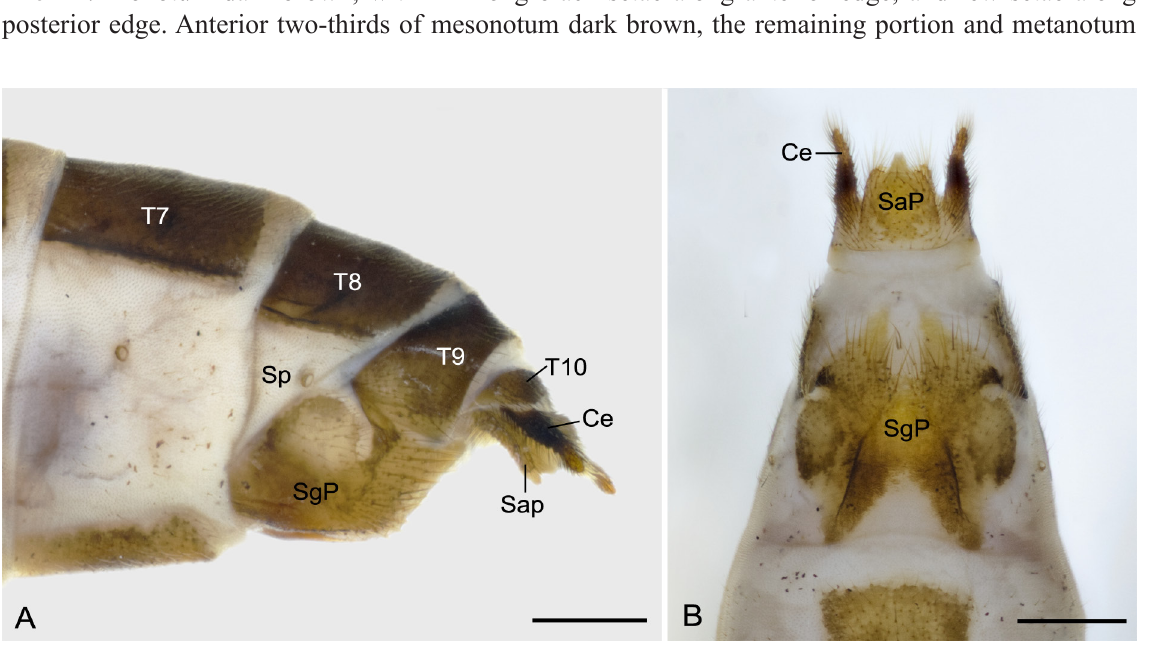
Fig. 8. Female terminalia of Terrobittacus angustus sp. nov. A . Lateral view. B . Ventral view. Abbreviations: Ce = cercus; SaP = subanal plate; SgP = subgenital plate; Sp = spiracle; T = tergum. Scale bars = 0.5